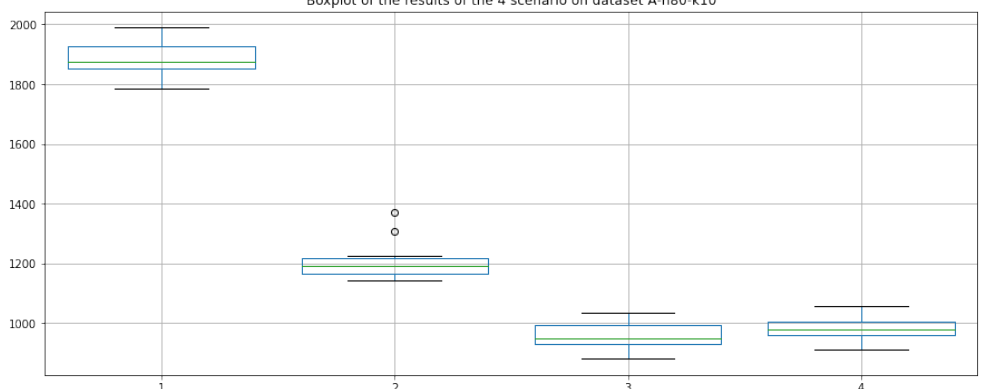
Figure 15. Boxplot of scenarios on the A-n80-k10 task of